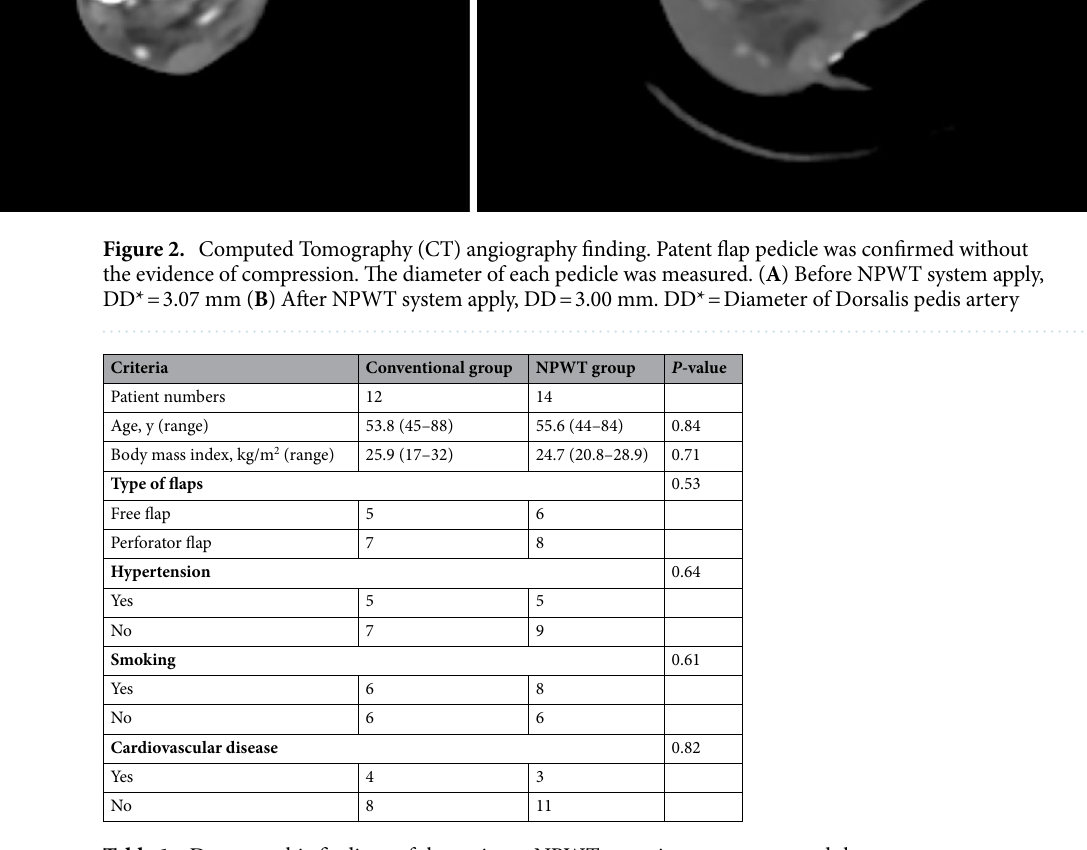
Table 1. Demographic findings of the patients. NPWT: negative pressure wound